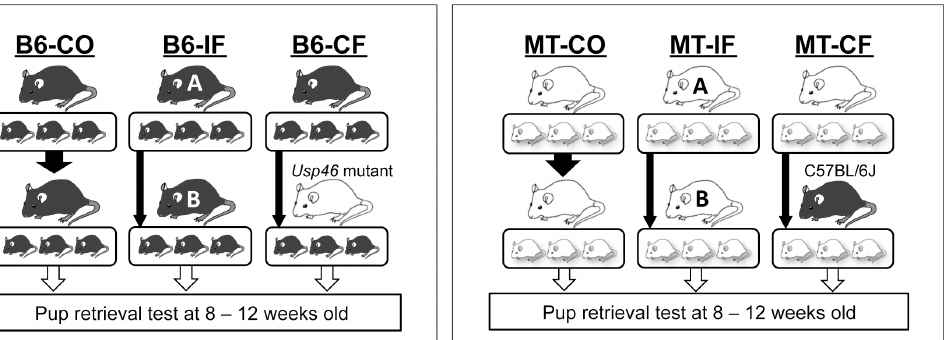
Fig 1. Outline of fostering experiments. B6-CO: B6 mice fostered by their biological mother. B6-IF: B6 mice fostered by a different B6 mother. B6-CF: B6 mice fostered by an MT mother. MT-CO: MT mice fostered by their biological mother. MT-IF: MT mice fostered by a different MT mother. MT-CF: MT mice fostered by a B6 mother. Offspring were tested at 8 – 12 weeks of